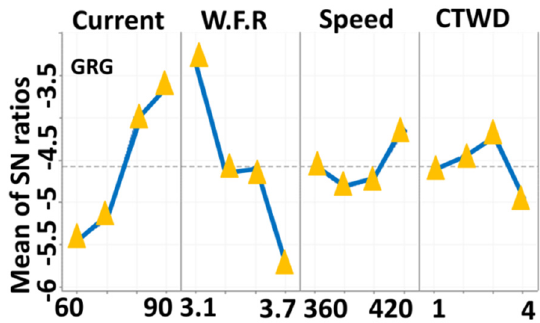
Figure 7. S/N ratio results for GRG.